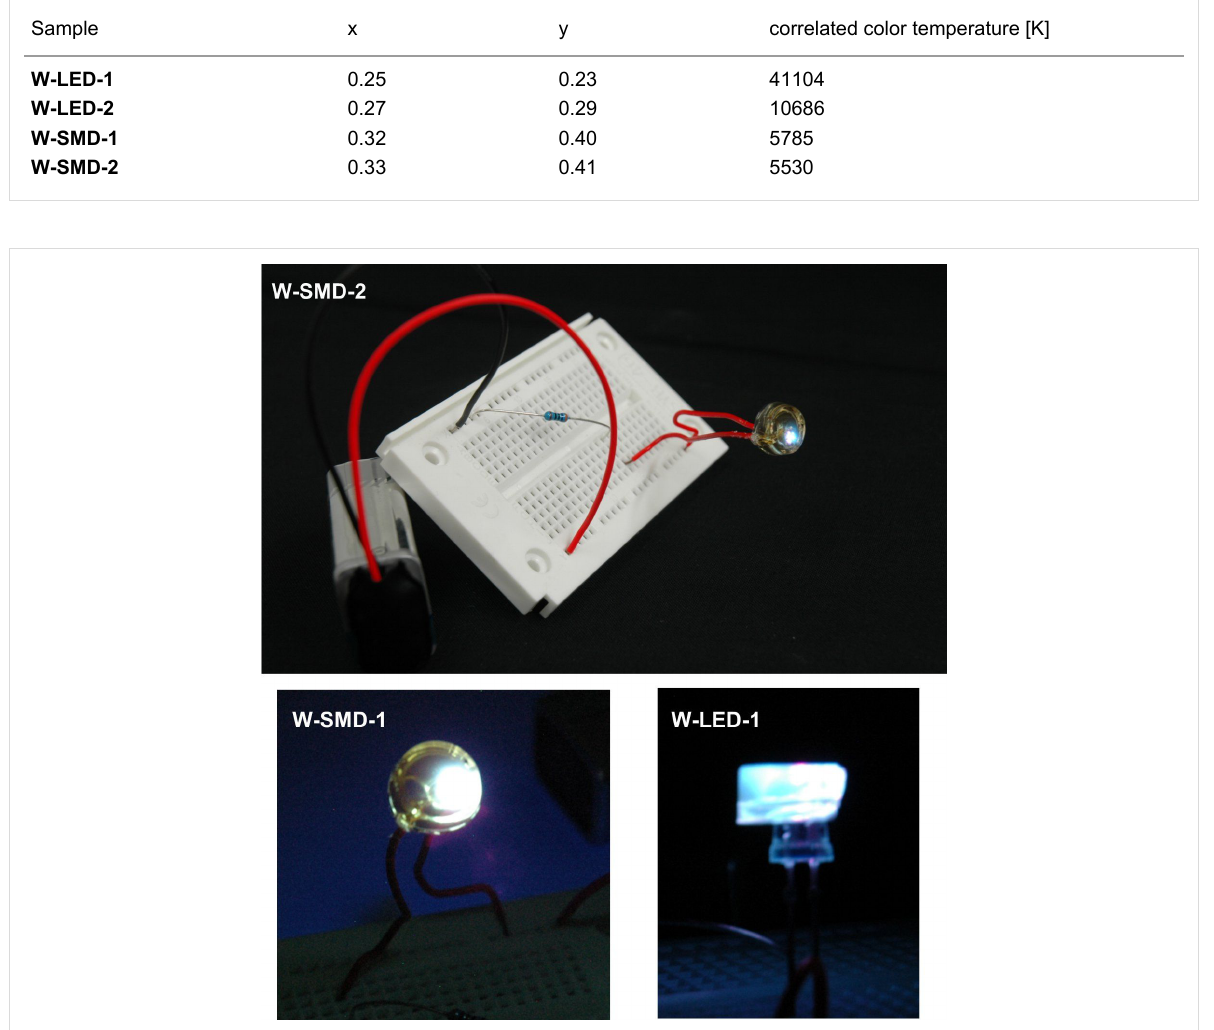
Figure 10: Pictures of the coated LEDs in compact device set-up (SMD) and conventional diode design